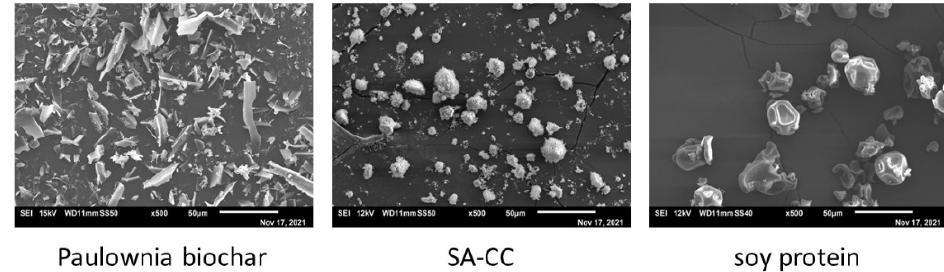
Figure 1. SEM images at 500 × of the three fillers used in this work. The small white bar in the lower right section of each SEM image represents 50 microns.